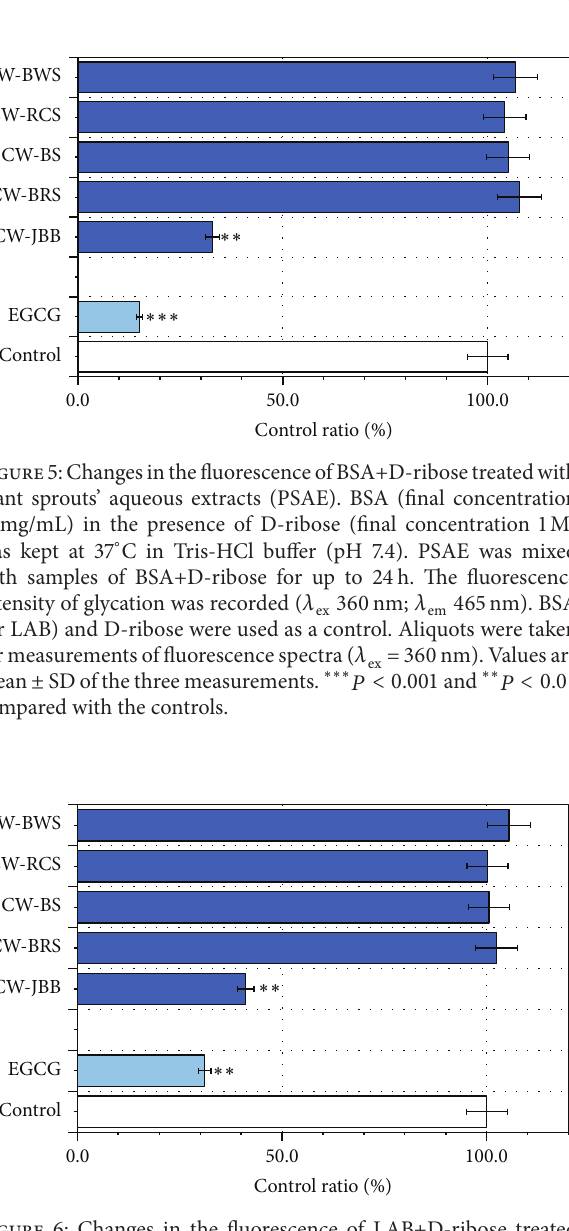
Figure 6: Changes in the fluorescence of LAB+D-ribose treated with plant sprouts’ aqueous extracts (PSAE). LAB (final concentra- tion10 mg/mL)inthepresenceofD-ribose(finalconcentration 1M) was kept at 37 ∘ C in Tris-HCl buffer (pH 7.4). PSAE was mixed with samples of LAB+D-ribose for up to 24 h. The fluorescence intensity of glycation was recorded ( 𝜆 ex 360 nm; 𝜆 em 465 nm). LAB and D- ribose were used as a control. Aliquots were taken for measurements of fluorescence spectra ( 𝜆 ex = 360 nm). Values are mean ± SD of the three measurements. ∗∗ 𝑃 < 0.01 compared with the